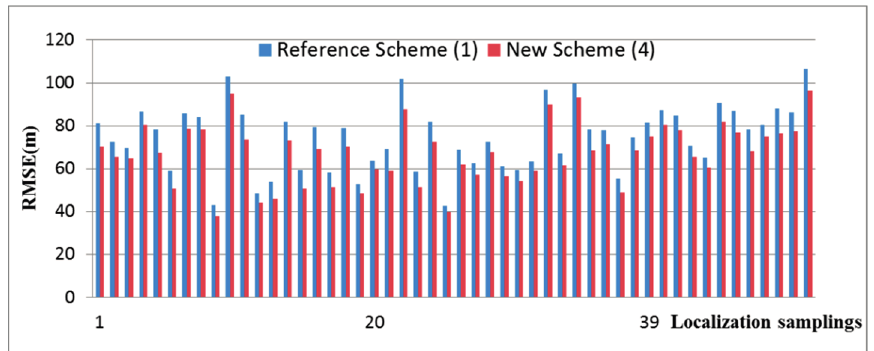
Figure 3. Comparison of reference scheme (1) and new scheme